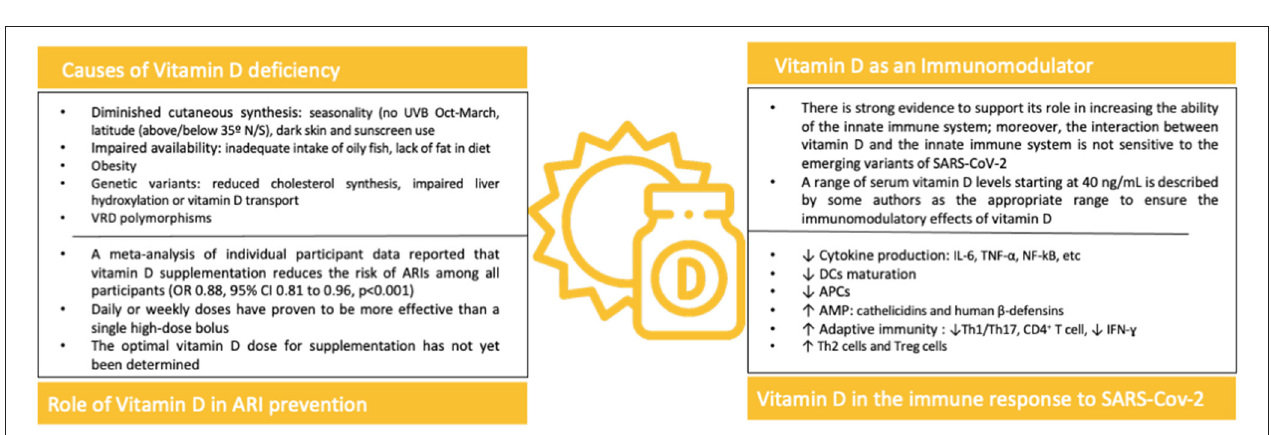
FIGURE 6 | Summary of key review